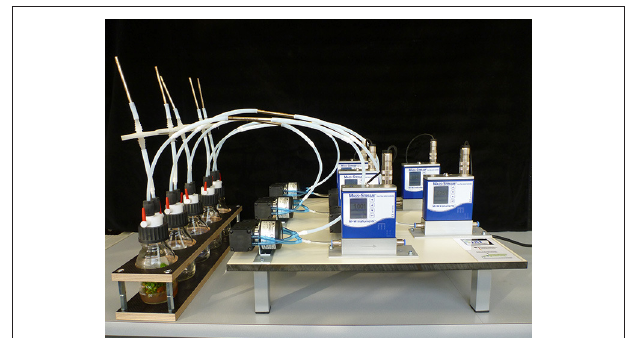
FIGURE 1 | Newly developed five-channel headspace sampling device enabling an exact quantitative measurement of VOCs in headspace samples from both in vitro plants (picture, left) or bigger plants. For detailed description compare material and methods. Photograph: Sabine Wetzel,